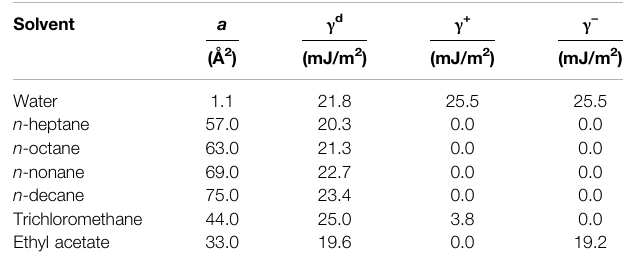
TABLE 2 | Characteristics of the Dispersive and Acid-Base IGC probes used in this